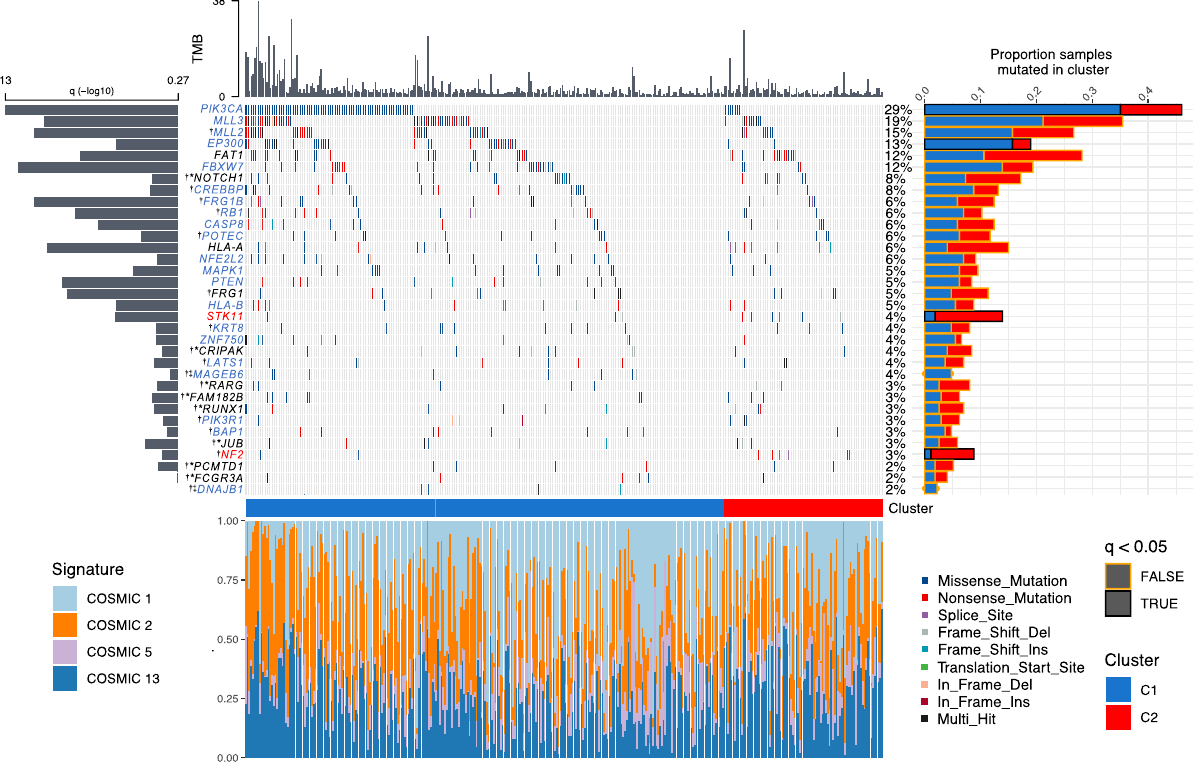
Fig. 4 | Genomic summary of signi fi cantly mutated genes (SMGs) in SCC cohorts. The central plot shows mutation type and frequencies for 34 SMGs identi fi ed using dNdSCV on TCGA, Bergen and Ugandan cohorts (367 total patients). The histogram above the main plot represents tumour mutation burden (TMB, mutations/megabase) per sample. The histogram to the left displays the statistical signi fi canceof each SMG while the histogram to the right represents the proportionof C1 (blue) and C2 (red)tumoursinwhich each gene ismutated. Black